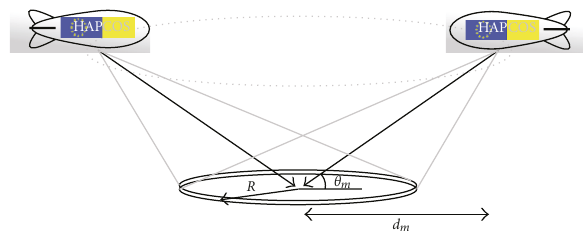
Figure 1: An example of a system simulation setup with N = 2 HAPs with overlapping cells of radius R . d m is the distance on the ground between the cell centre and the vertical projection of the HAP on the ground and θ m is the elevation angle towards the HAP.